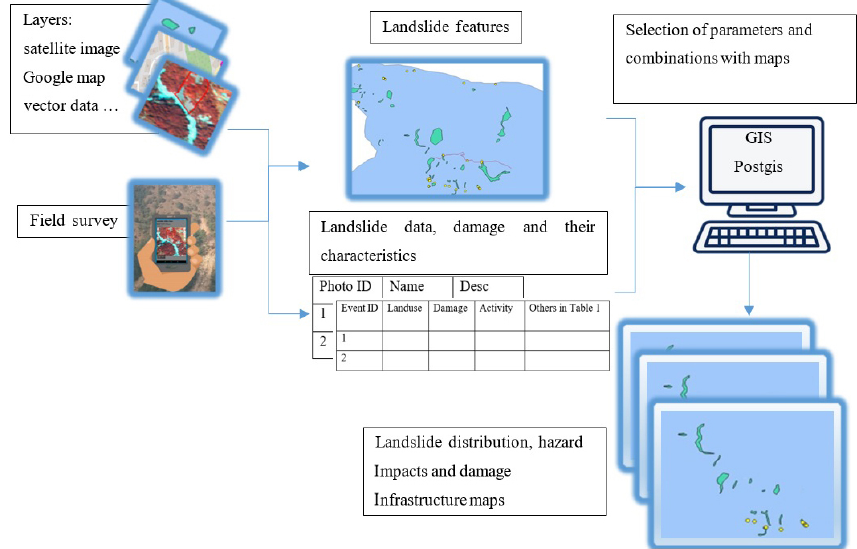
Figure 3. Workflow of ROOMA where coupled image interpolation with field survey leads to valuable maps and a complete database of landslide data and their characteristics. These different maps of landslide distribution, hazard, and damage infrastructure can be produced by manipulation in